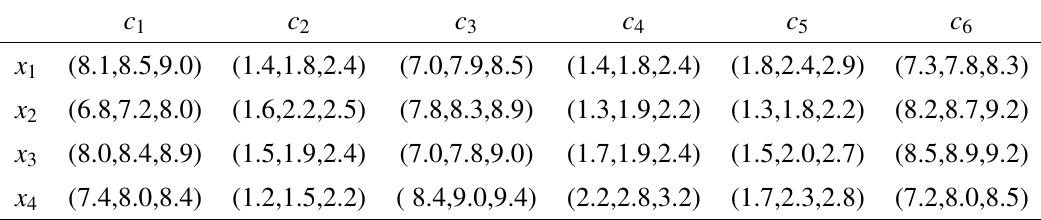
Table 4: Decision matrix given by DM5 after the first round of interactive